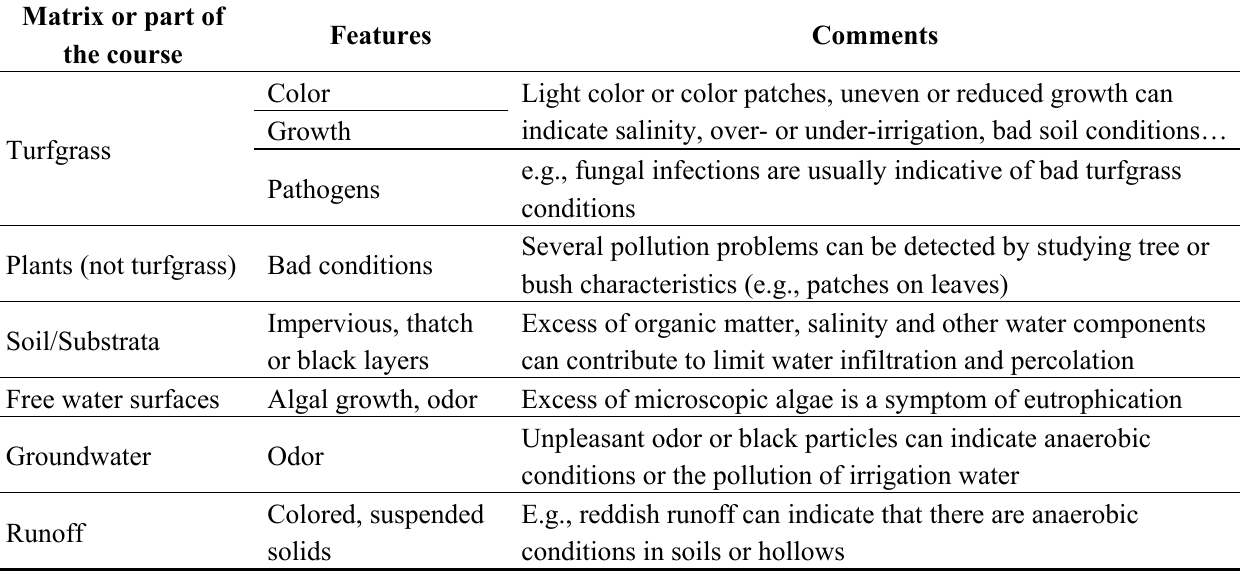
Table 12. Examples of observation tools on a golf